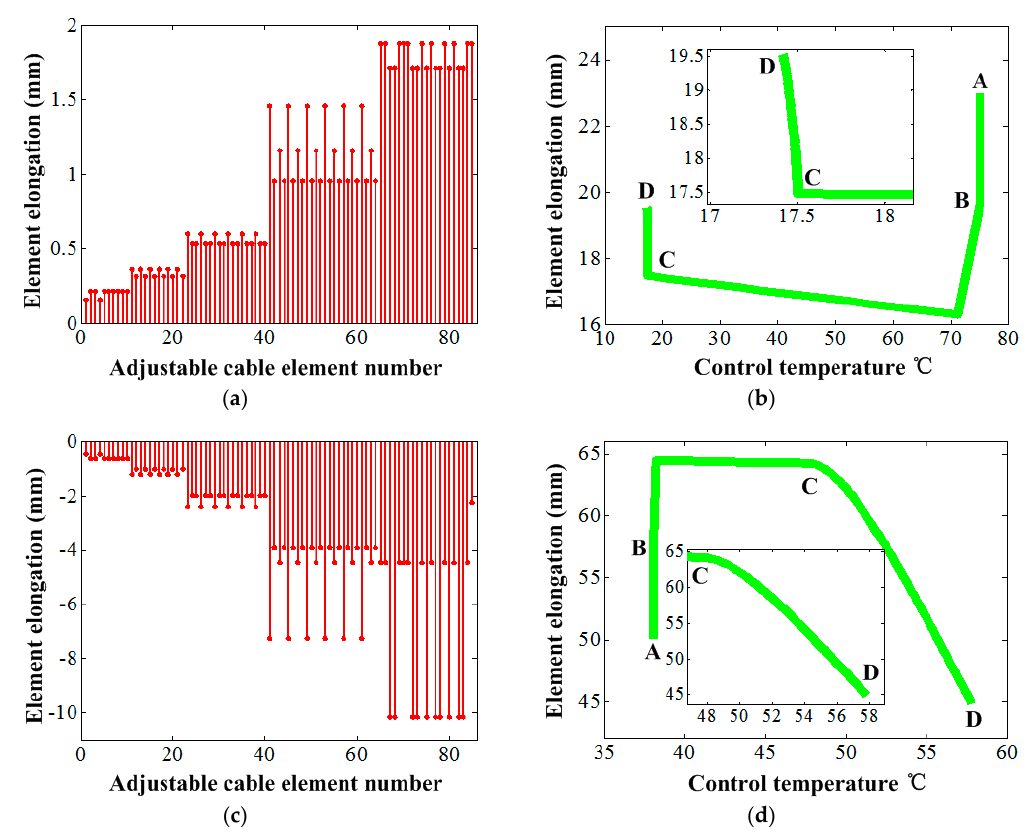
Figure 7. Element elongation under the control temperature: ( a ) Variations of all elements of vertical cables under environment temperature 140 °C, ( b ) single element change under environment temperature 140 °C, ( c ) variations of all elements of vertical cables under environment temperature − 100 °C and ( d ) single element change under environment temperature − 100 °C.